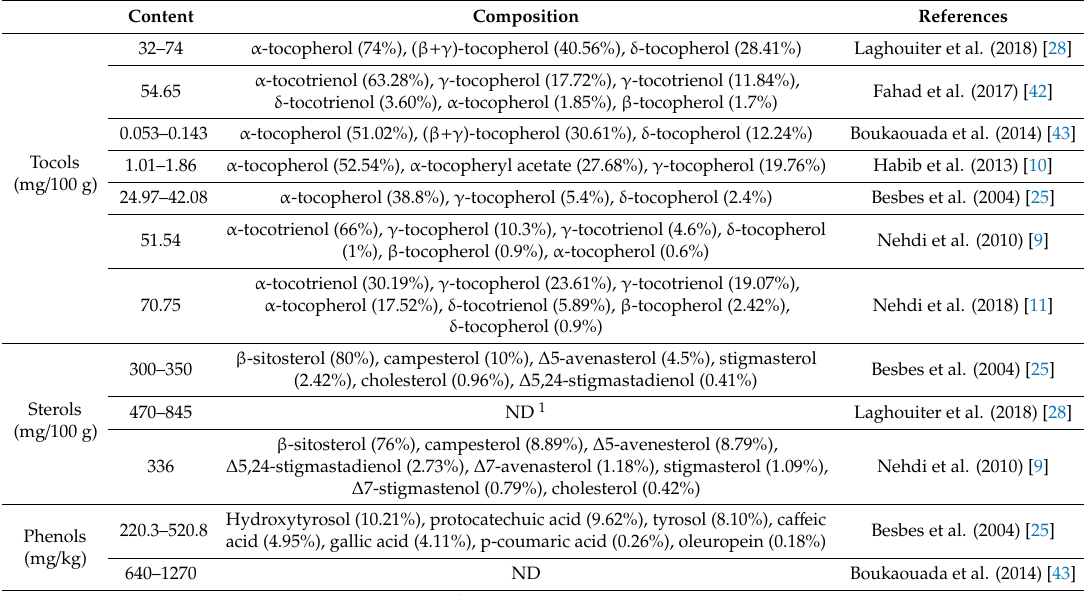
Table 2. Unsaponifiable components of date seed